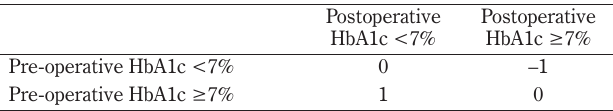
Table 1 Cut-off points and scores for adjusted treatment